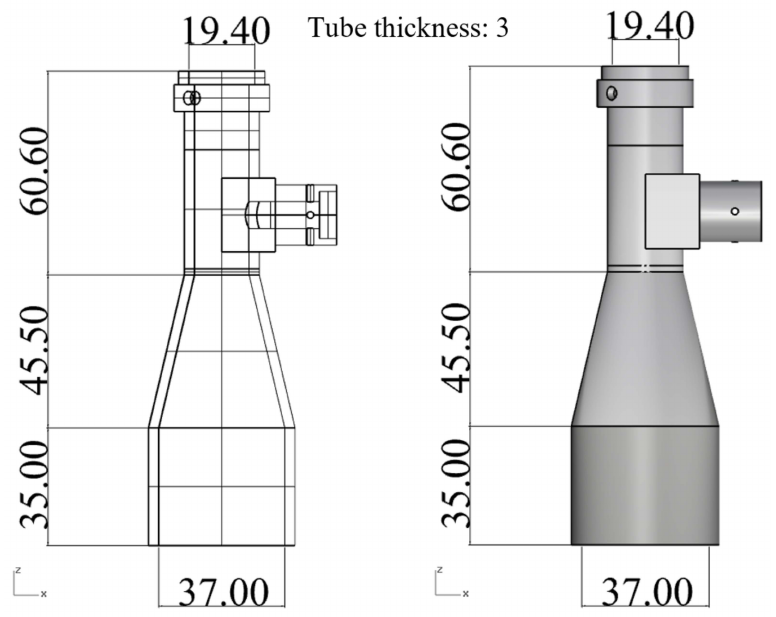
Figure 5. Designed geometry of telecentric lens (unit: